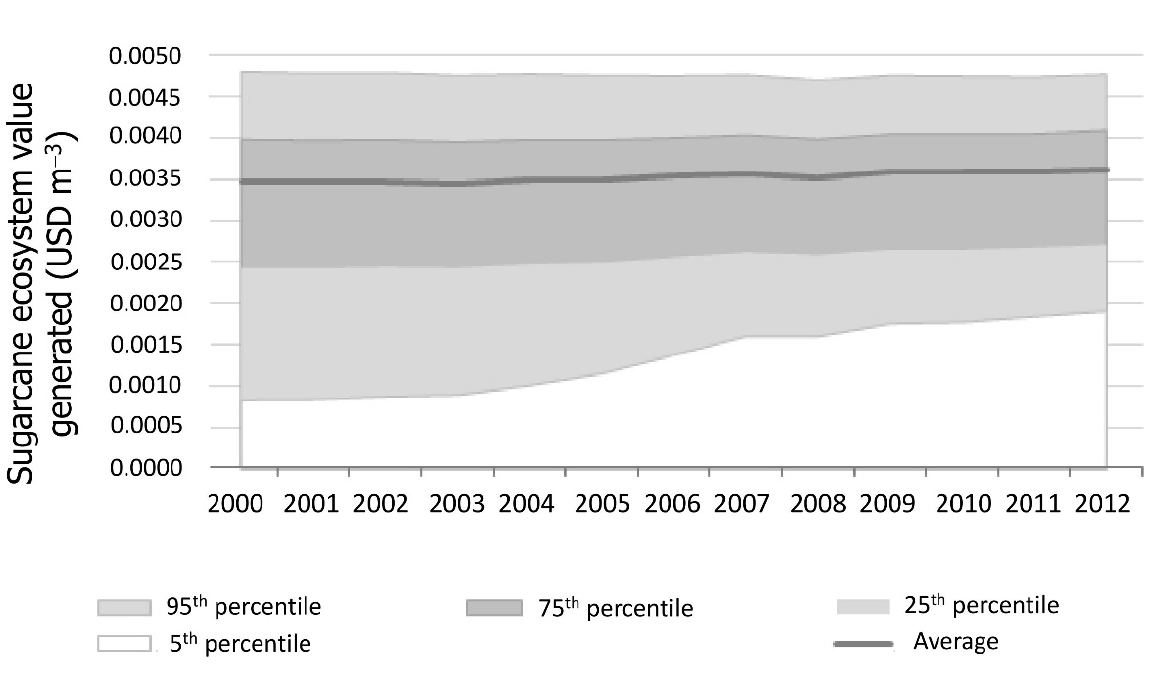
Figure 4. Average, as well as 5th, 25th, 75th, and 95th percentiles of sugarcane ES value per unit of water (USD m − 3 ).